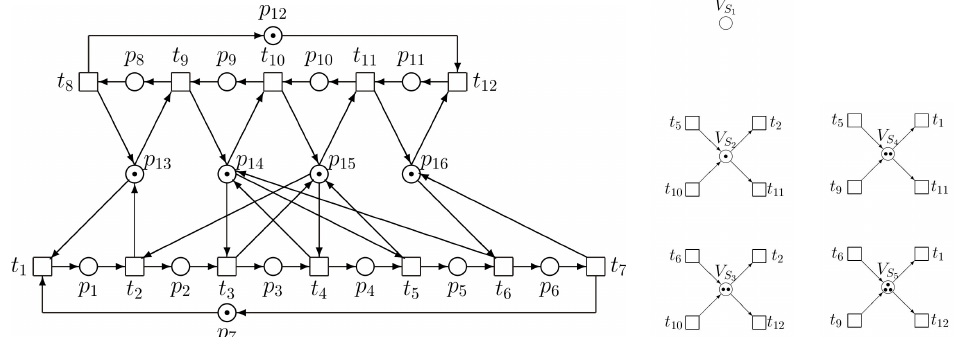
Figure 8. The PN model ( left ) with its supervisor ( right ) created by five monitors and their inter- connections with the uncontrolled model. The monitor V S incidence matrix N c in (41).